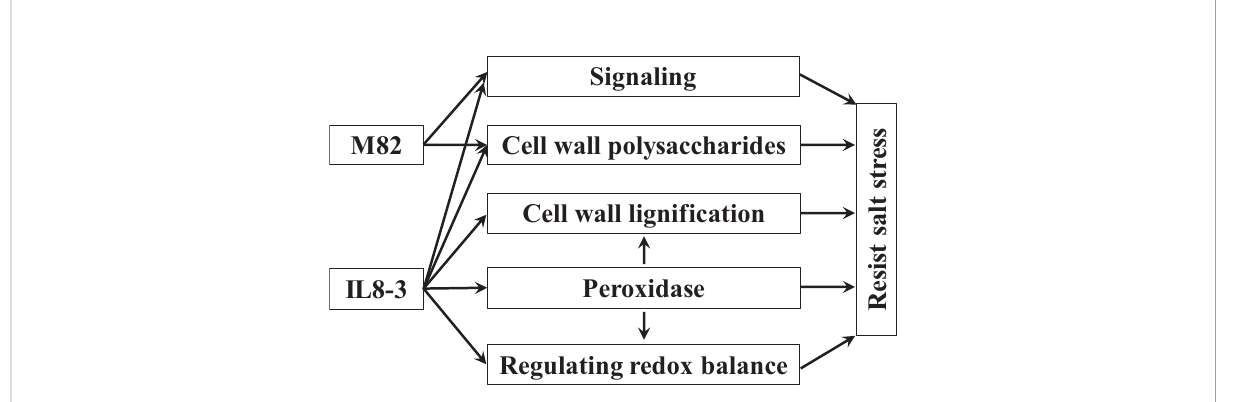
FIGURE 5 A proposed model of salt tolerance in tomato based on the cell wall proteomics of seedling roots. Arrows denote positive